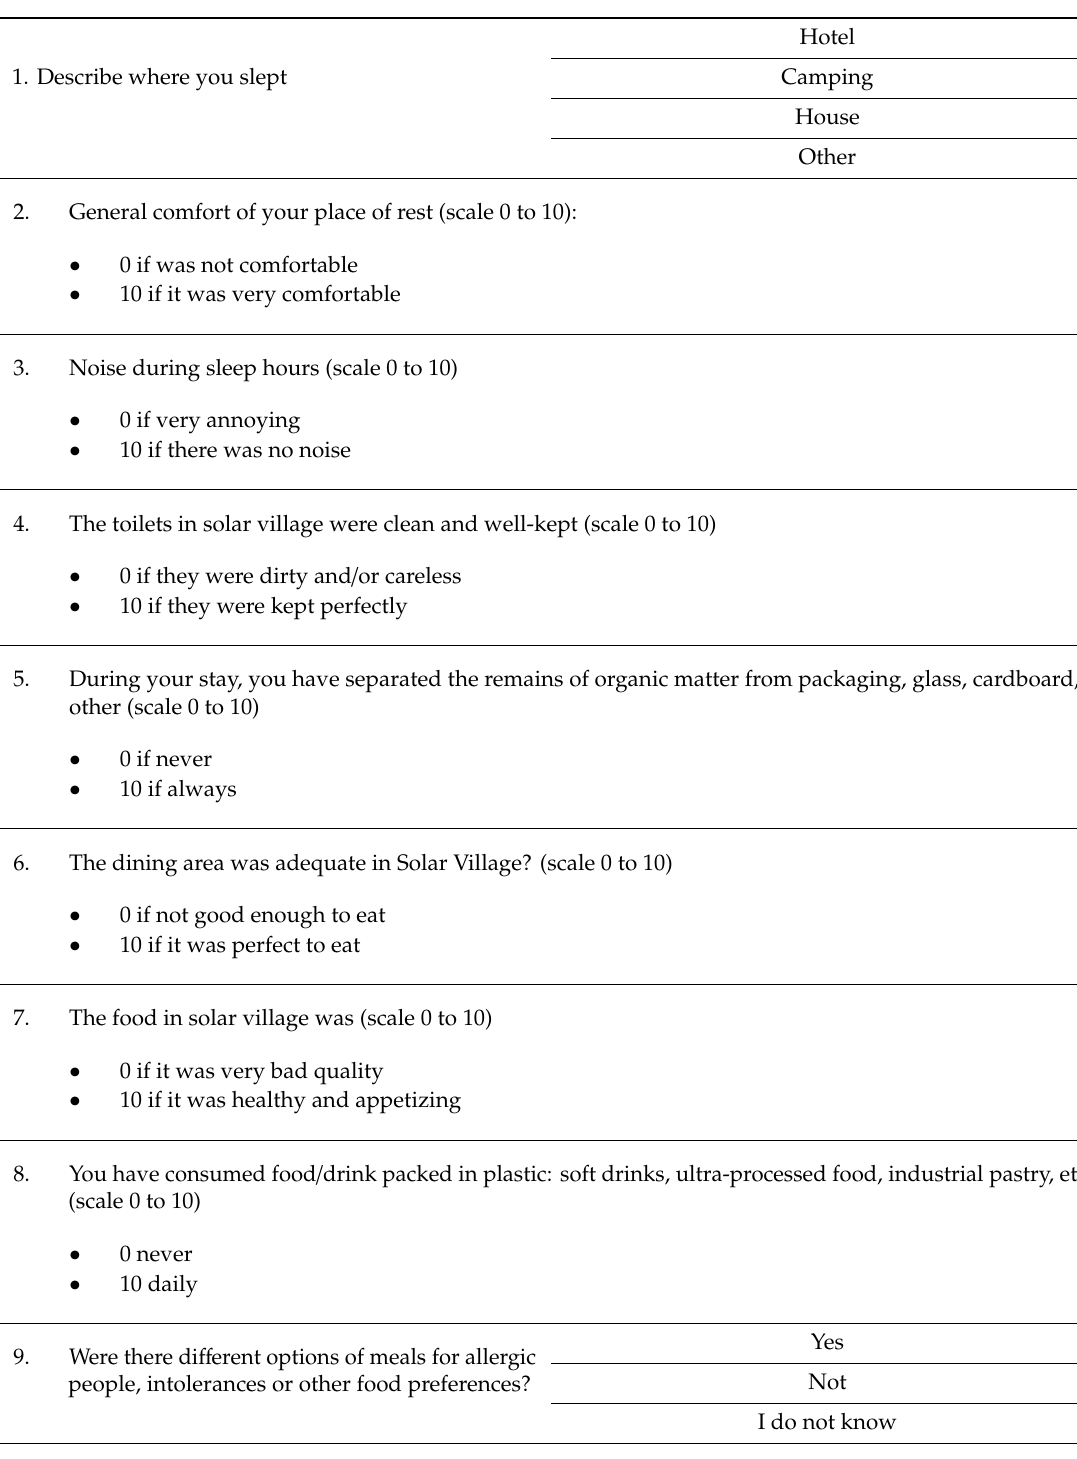
Table 5. Comfort